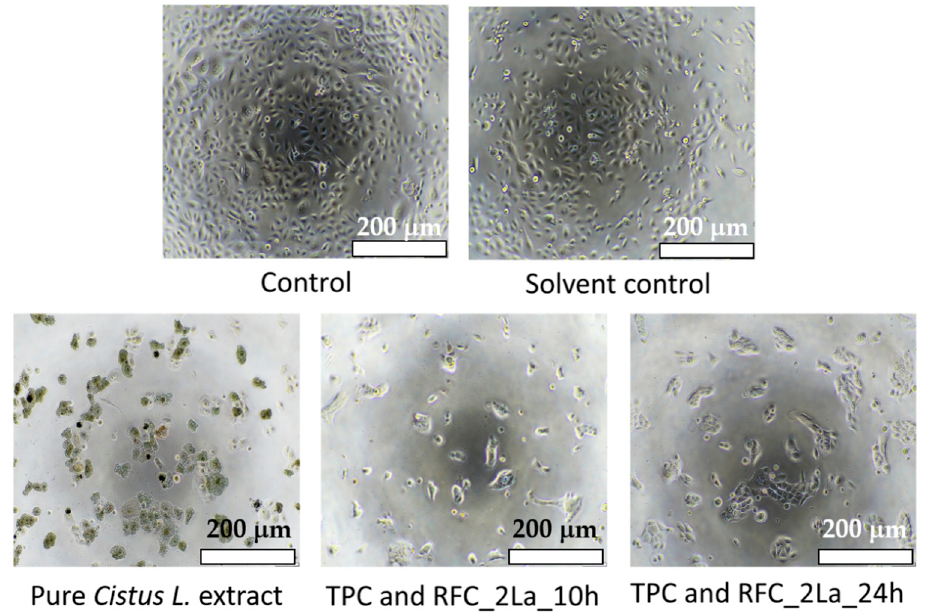
Figure 7. Images of the Ker-CT cell line were obtained with an inverted phase contrast microscope after 24 h of incubation without the Cistus L. extract (Control), diluted with water (Solvent control) and with Cistus L. extract Pure Cistus L . extract, TPC and TFC_2La_10h and TPC and TFC_2La_24h.